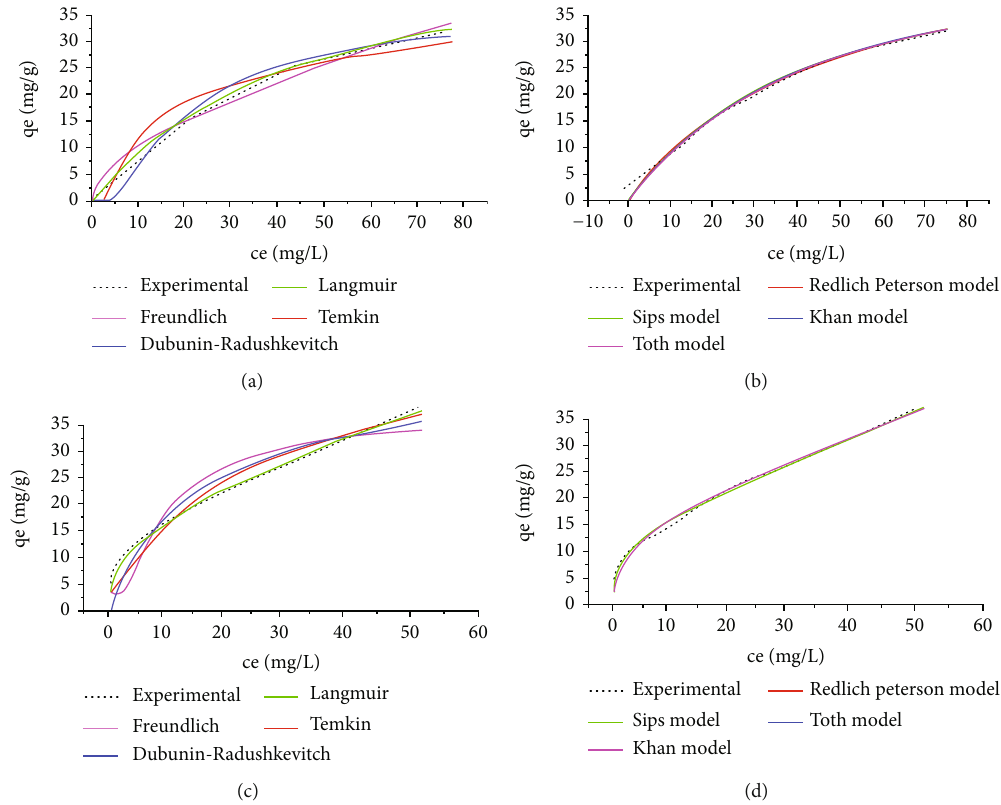
Figure 11: Adsorption isotherm of two-parameter and three-parameter models of Red 2BN adsorption on (a, b) JPAC and (c, d) JPAC/TiO Table 6: Intraparticle di ff usion rate parameter and di ff usion coe ffi cient for the adsorption of Red 2BN on JPAC and JPAC/TiO C (mg/L) id 0 (mg/g.min 0.5 )